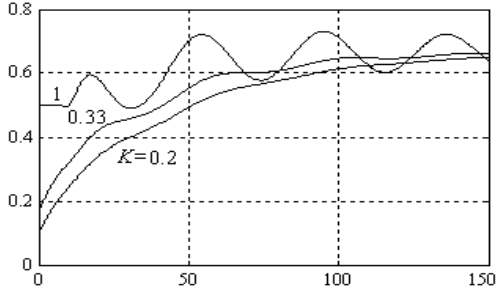
Figure 23. Control responses u ( t ) to a unit step reference for K = 0.2; 0.33; 1.